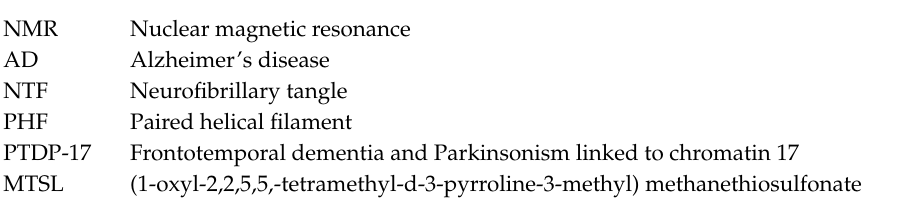
Figure S4. PRE data for the P301L mutant TauF4 ∆ . Figure S5. Small-angle X-ray scattering (SAXS) curves for the wild-type (black) and P301L mutant (red) TauF4 ∆